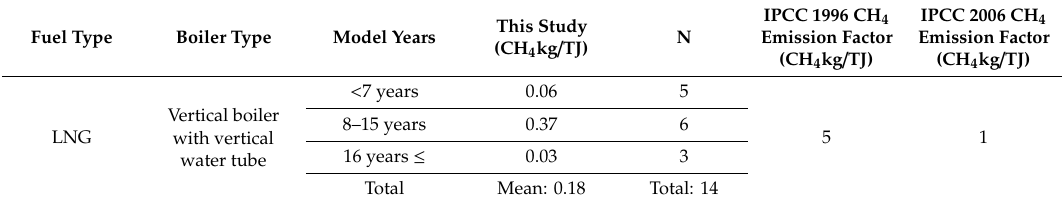
Table 5. CH 4 emission factor of LNG boiler model years.